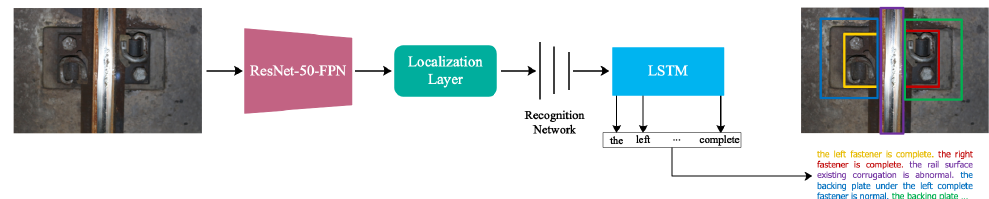
Figure 3. Network architecture of RTLCap. ResNet-50-FPN is used instead of VGG16 as the back- bone